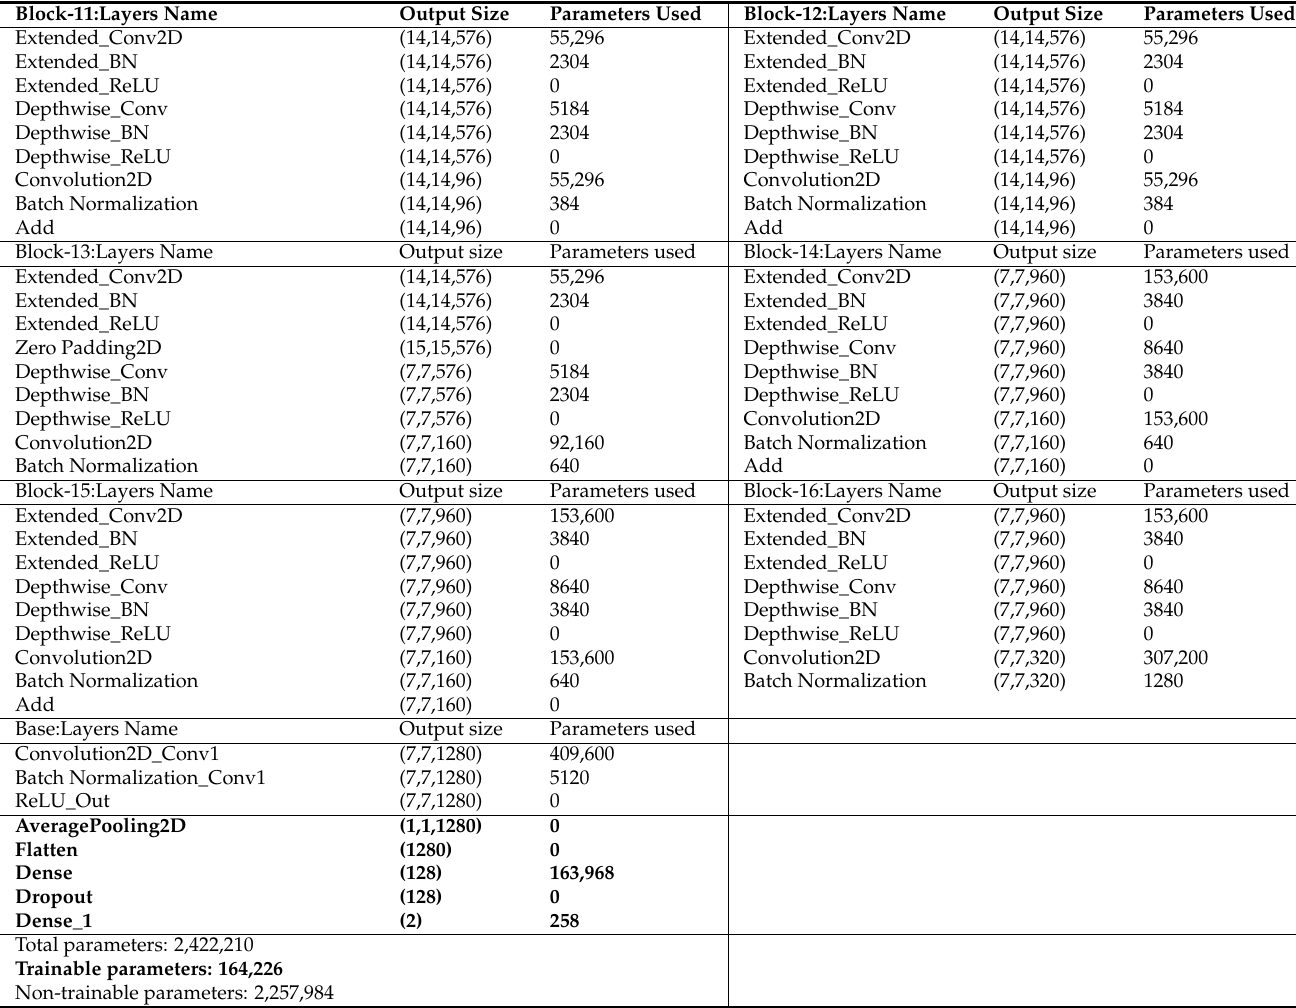
Table 2. Architecture of the Proposed